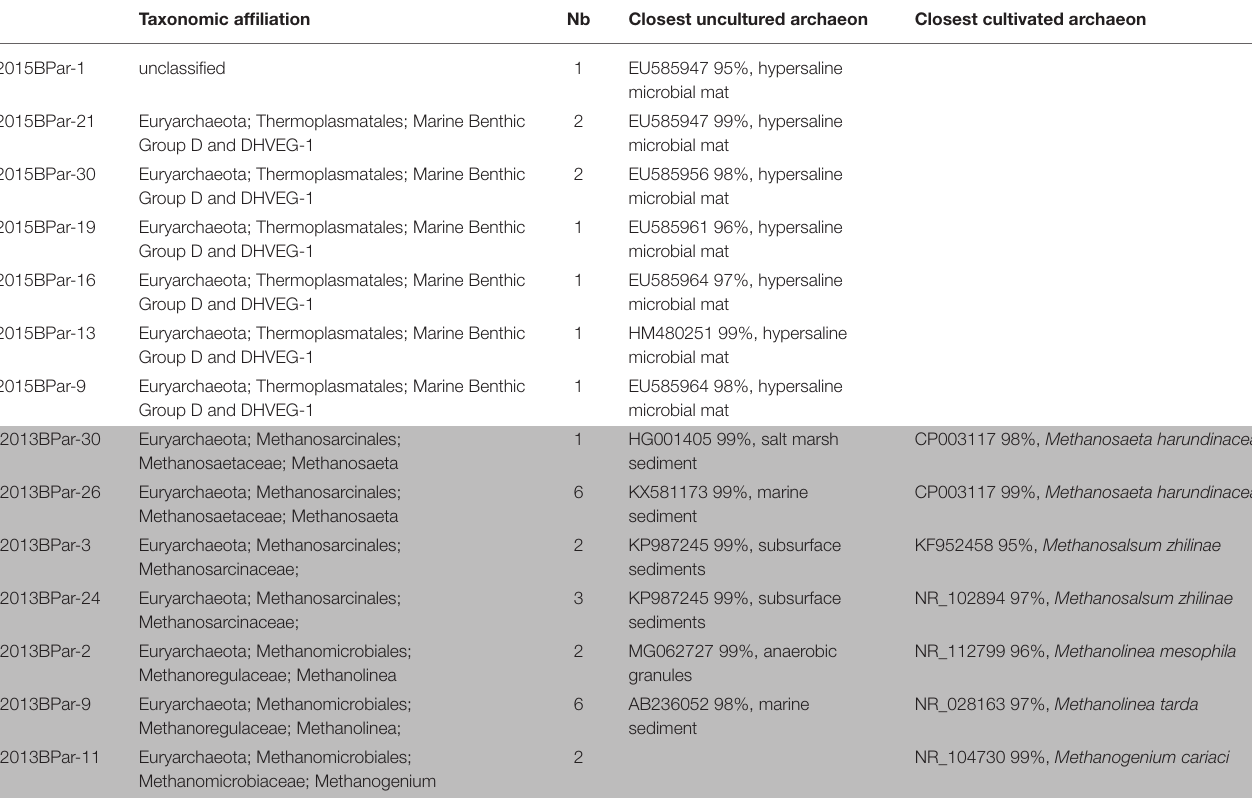
TABLE 3 | Taxonomic affiliations of the archaeal 16S rRNA gene sequences using general archaeal primers retrieved from the BP mats collected in 2013 (gray) and 2015 (white). Nb stands for number of clones. Taxonomic affiliation Nb Closest uncultured archaeon Closest cultivated archaeon 1 EU585947 95%, hypersaline microbial mat